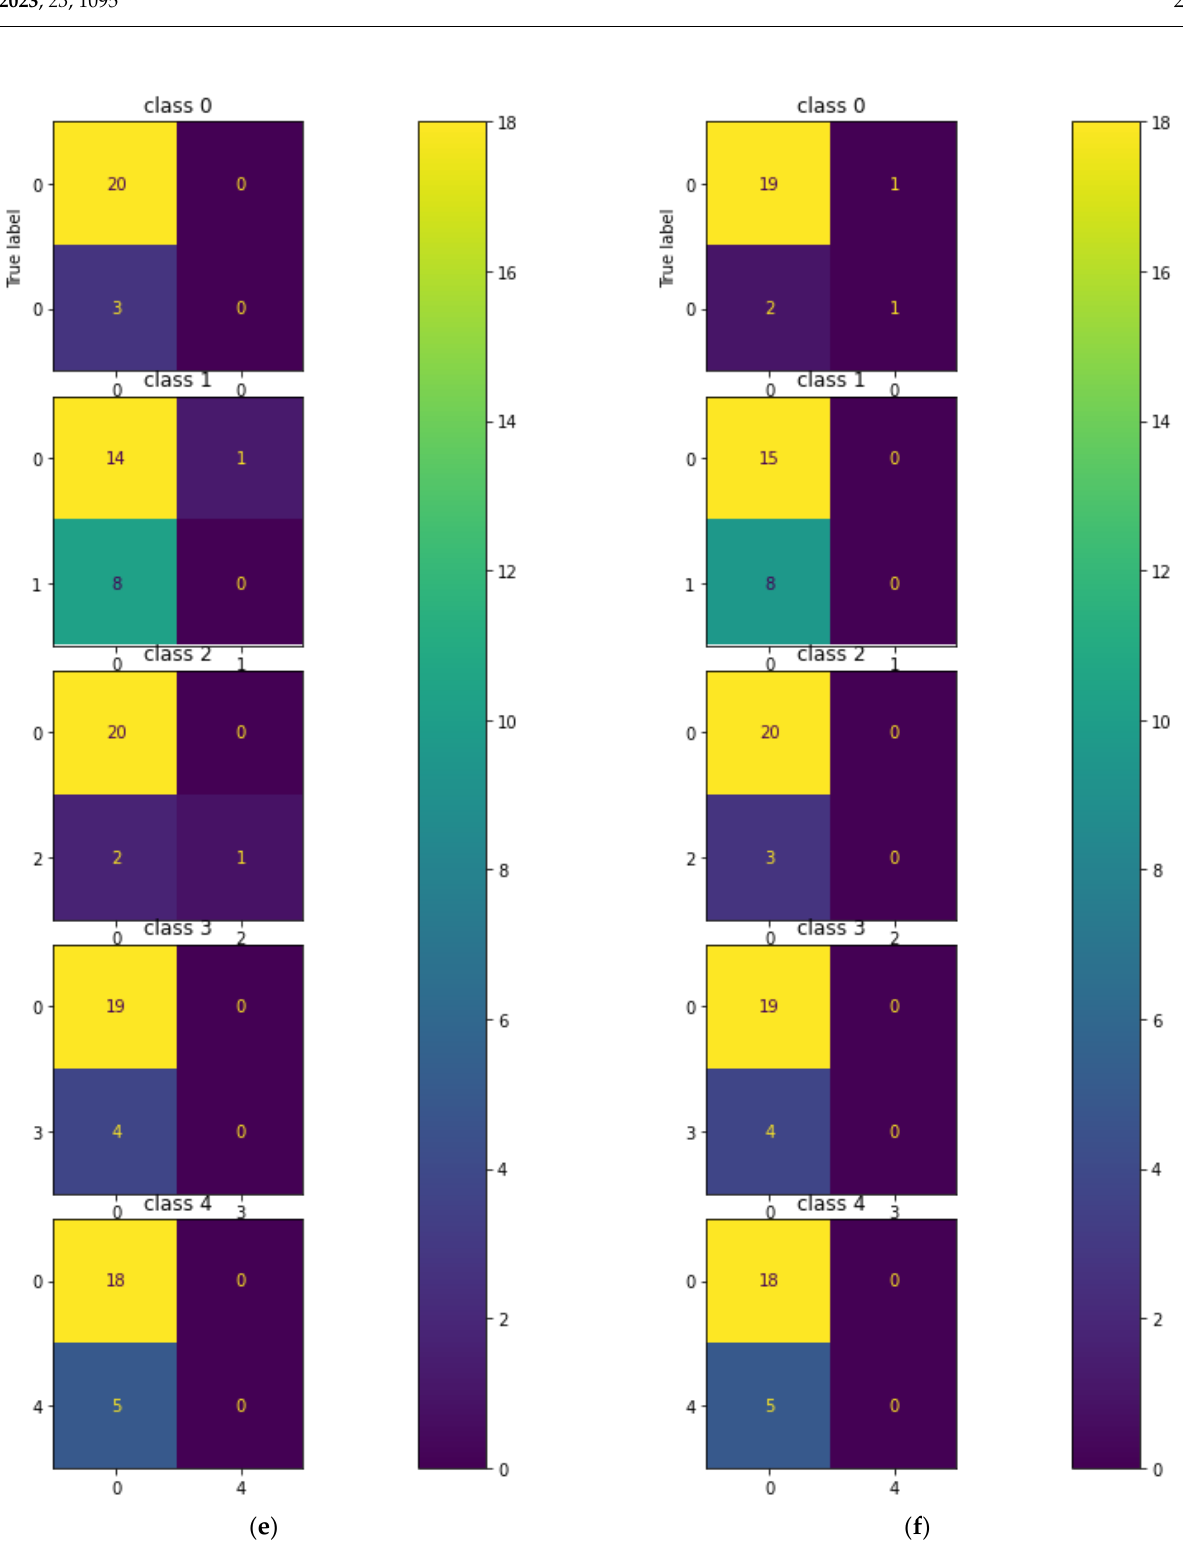
Figure 16. Five-class error matrix for the phase-only image dataset: ( a ) CNN; ( b ) KNN; ( c ) MLP; ( d ) DT; ( e ) RF; ( f ) ET.